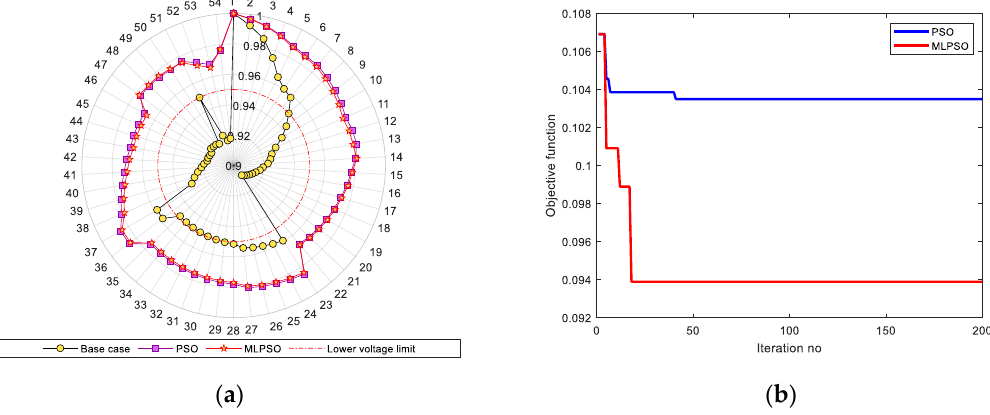
Figure 11. Variation of ( a ) voltage with a single DG, ( b ) convergence characteristics with a single DG, ( c ) voltage with two DGs, ( d ) convergence characteristics with two DGs, ( e ) voltage with three DGs, ( f ) convergence characteristics with three DGs for the Malaysian test